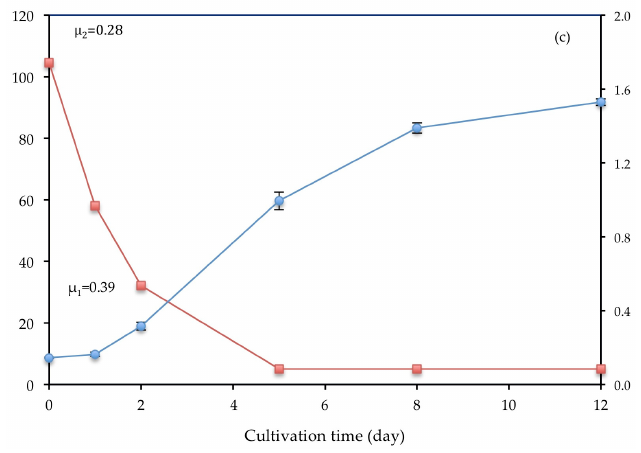
Figure 7. ( a ) Control ( b ) T1 ( c ) T2. Optical density of C. vulgaris and depletion of NH 4 -N (mg L − 1 ). Bars represent SD for optical density.